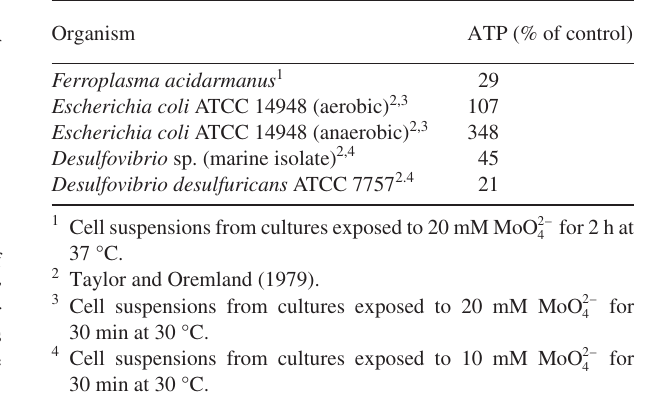
Table 1. Effect of molybdate on cellular ATP